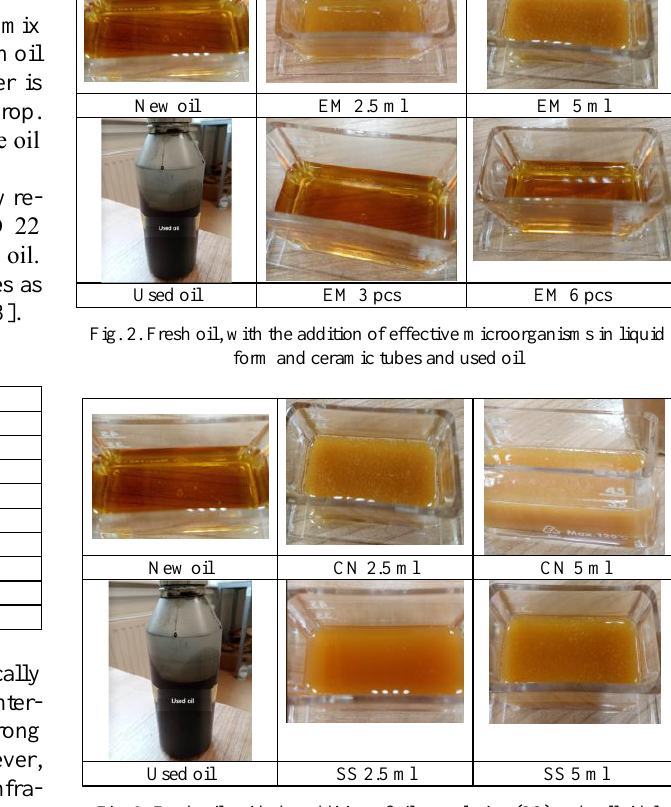
Fig. 3. Fresh oil, with the addition of silver solution (SS) and colloidal nanosilver (CN) in liquid form and used oil Effective microorganisms in liquid form (2.5 ml and 5 ml per 100 ml of oil) and in the form of ceramic tubes (3 pieces and 6 pieces with a diameter of 9 mm and a height of 11 mm for 100 ml of oil) was added to fresh and used oil. sented in Fig. 4 were used for the research.